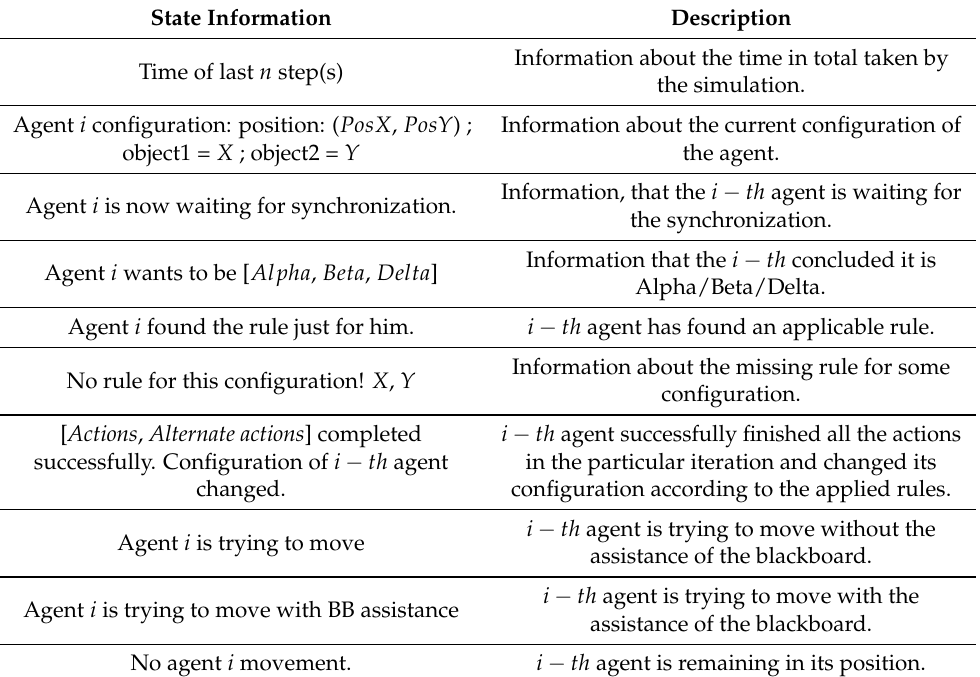
Table 5. State information of the agents. State Information Description